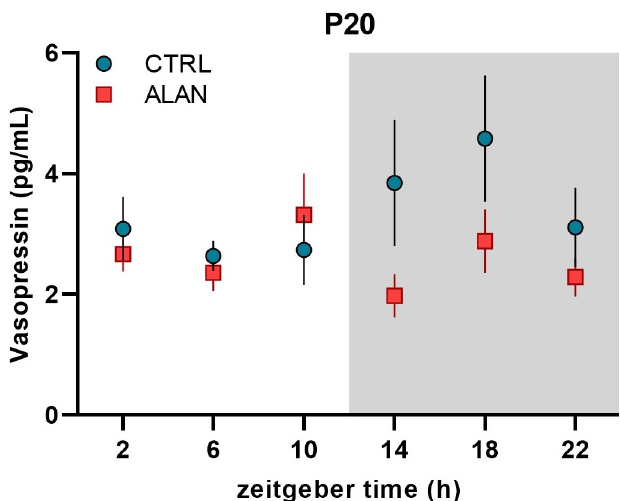
Figure 3. Effects of gestational dim ALAN (~2 lx) on the daily profile of plasma vasopressin levels in 20-day-old rat pups that were delivered by mothers exposed to either the control light–dark cycle (CTRL) or ALAN during pregnancy. Symbols represent the mean ± SEM, n = 5–6 rats per time point and group. Zeitgeber time 0 = light on. The grey area represents the dark